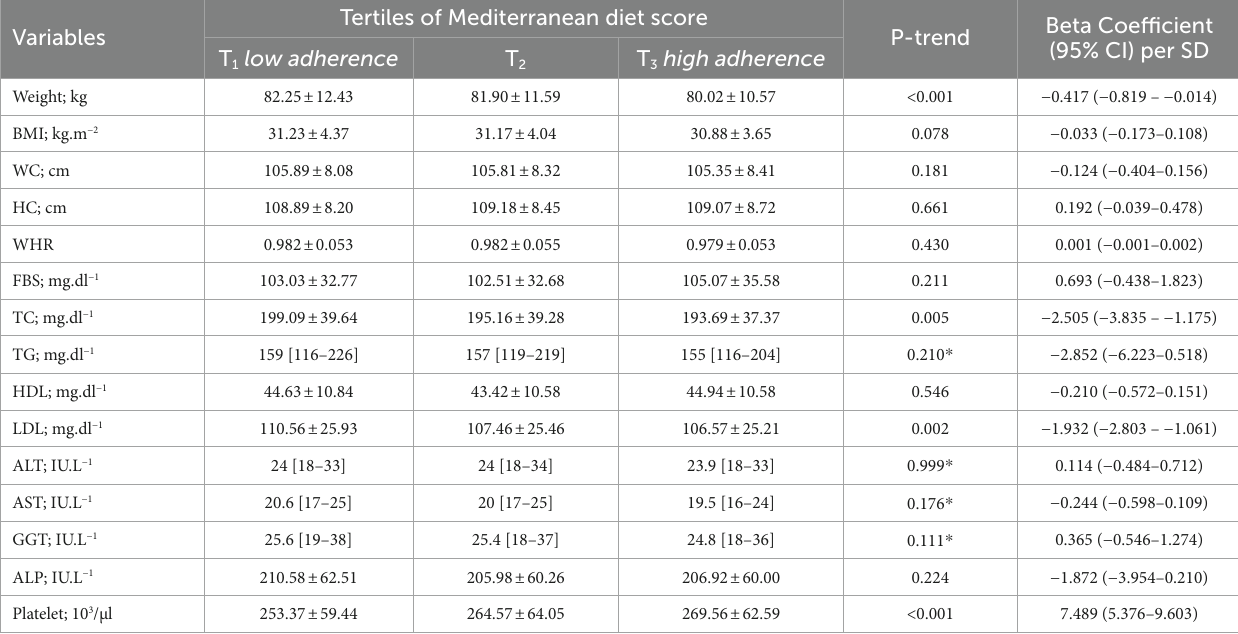
TABLE 3 Association of the Mediterranean diet scores with anthropometric and biochemical characteristics in patients with NAFLD defined through the FLI.